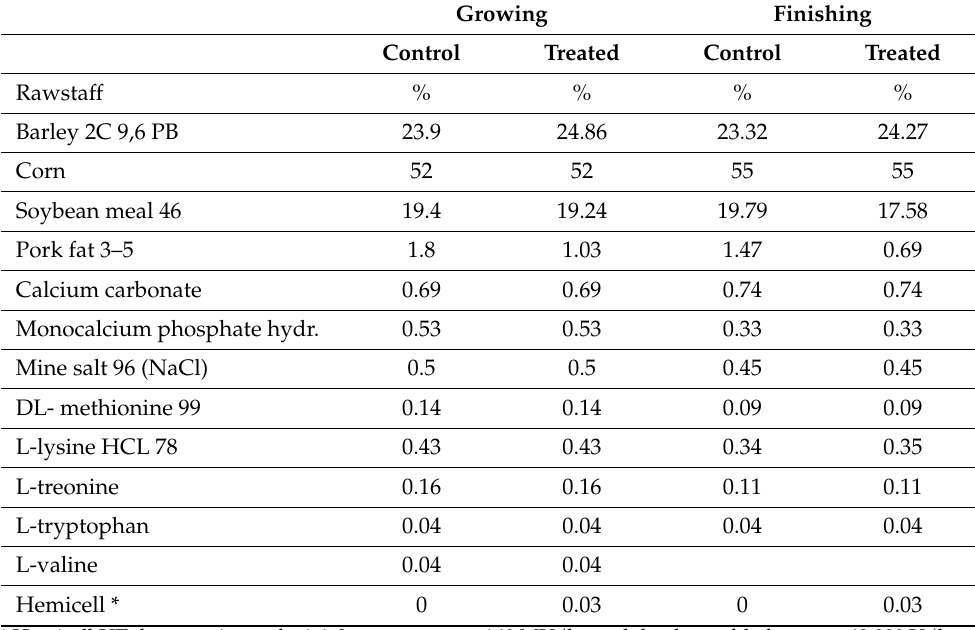
Table 1. Feed composition for growing and finishing.